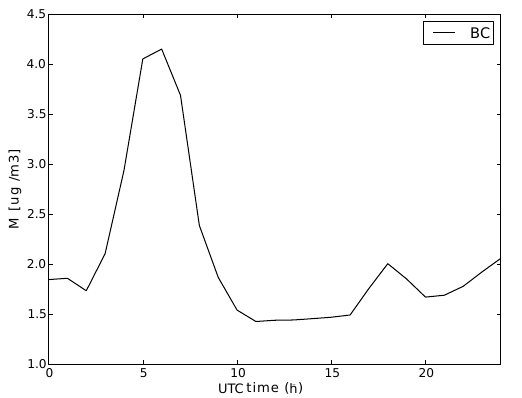
Figure 6. Transport BC concentration profile of 1 July 2009.